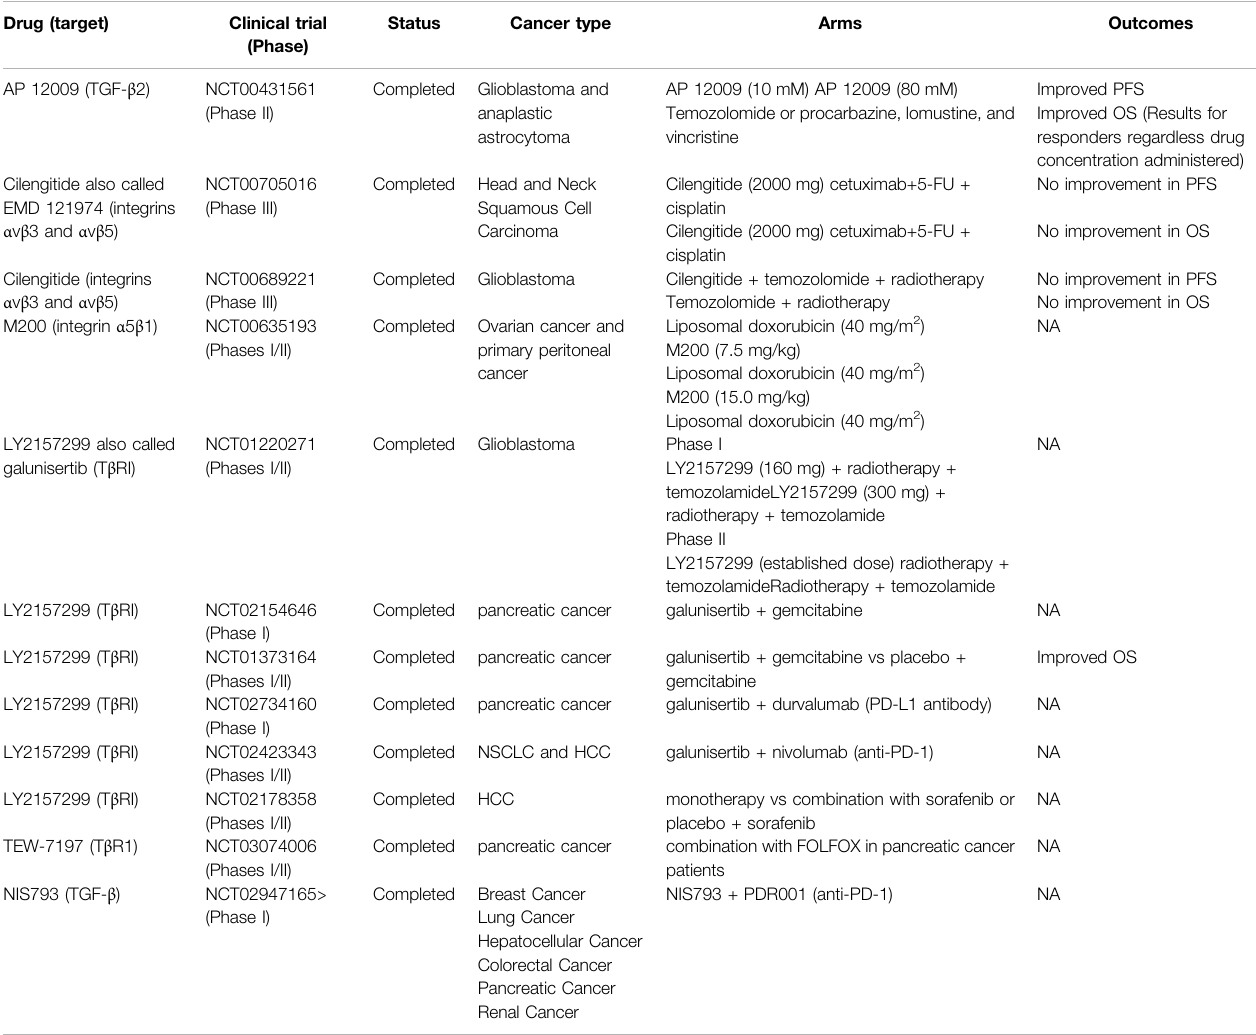
TABLE 1 | Overview of combination anti-TGF- β therapy with other cancer therapies in clinical trials. Drug